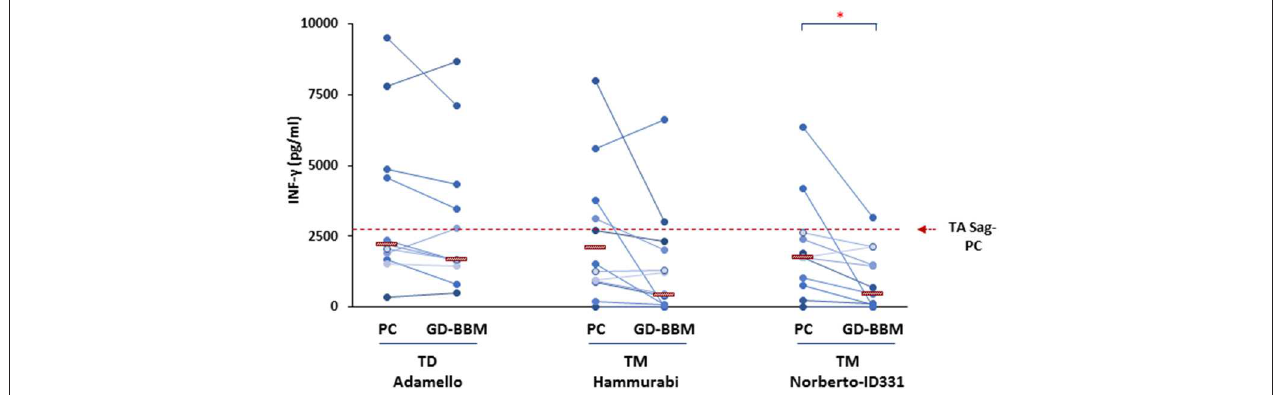
FIGURE 2 | Levels of INF- γ produced after in vitro stimulation of intestinal T-cell lines derived from ( N = 12) adult and young celiac disease (CD) patients. Either partial (PC) and extensive (GD-BBM)-digested gliadins (50 µ g/ml) from T. durum (Adamello cv ) and T. monococcum (Hammurabi and Norberto-ID331 cvs ) wheats were used as antigen to stimulate T cells. INF- γ was detected in cell supernatants after 48h of incubation by standard sandwich ELISA. Dashes indicate the median values of responses. Dashed red line indicates the median IFN- γ values produced in response to PC-gliadin from hexaploid wheat (positive control). Statistical analysis were performed by unpaired Student t -test to compare the INF- γ production found in response to gliadin samples differentially digested. * p < 0.05 is considered statistically significant.